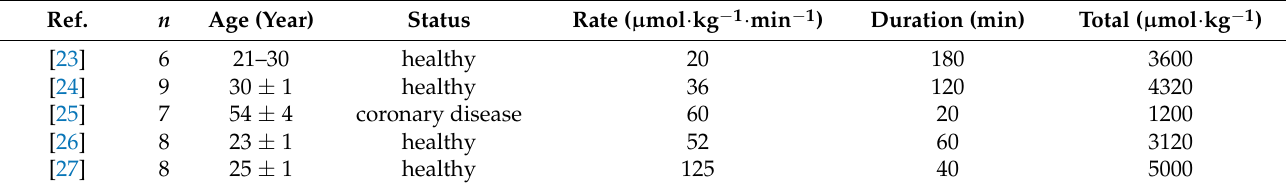
Table 1. Dose rates and durations investigated in healthy volunteers.